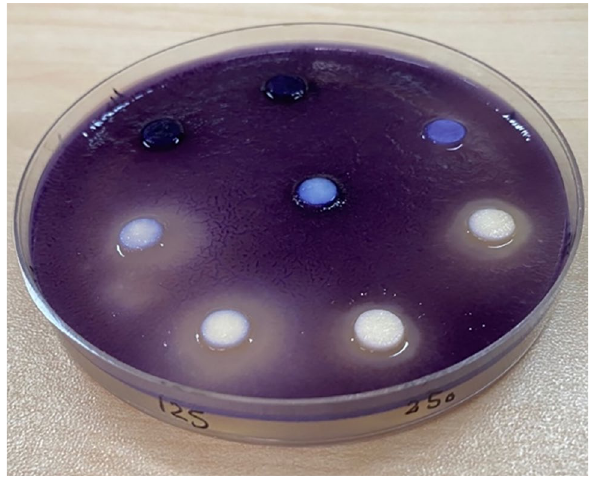
Figure 4. The qualitative anti-QS activity of different concentrations of AME.